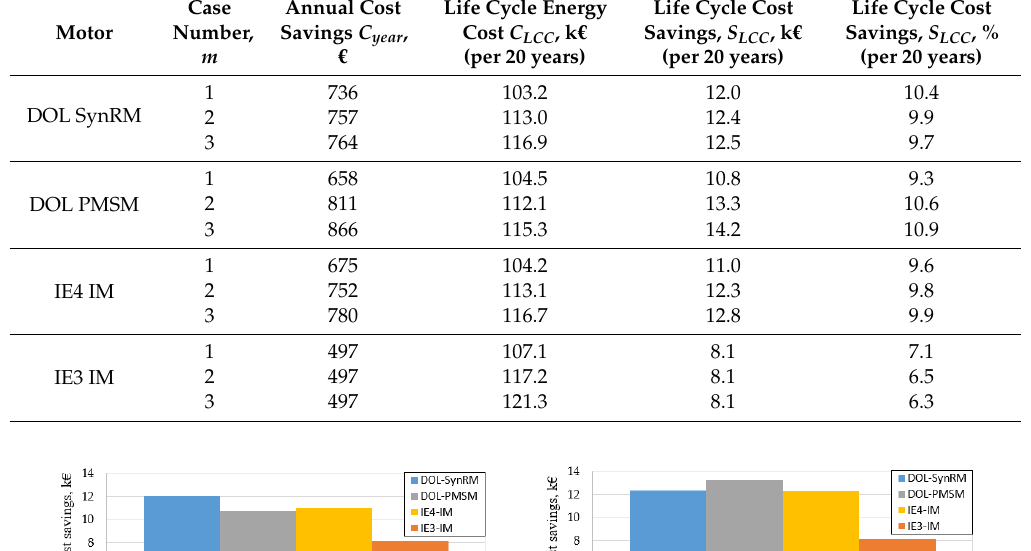
Table 9. Results of the life cycle costs for various considered cases.